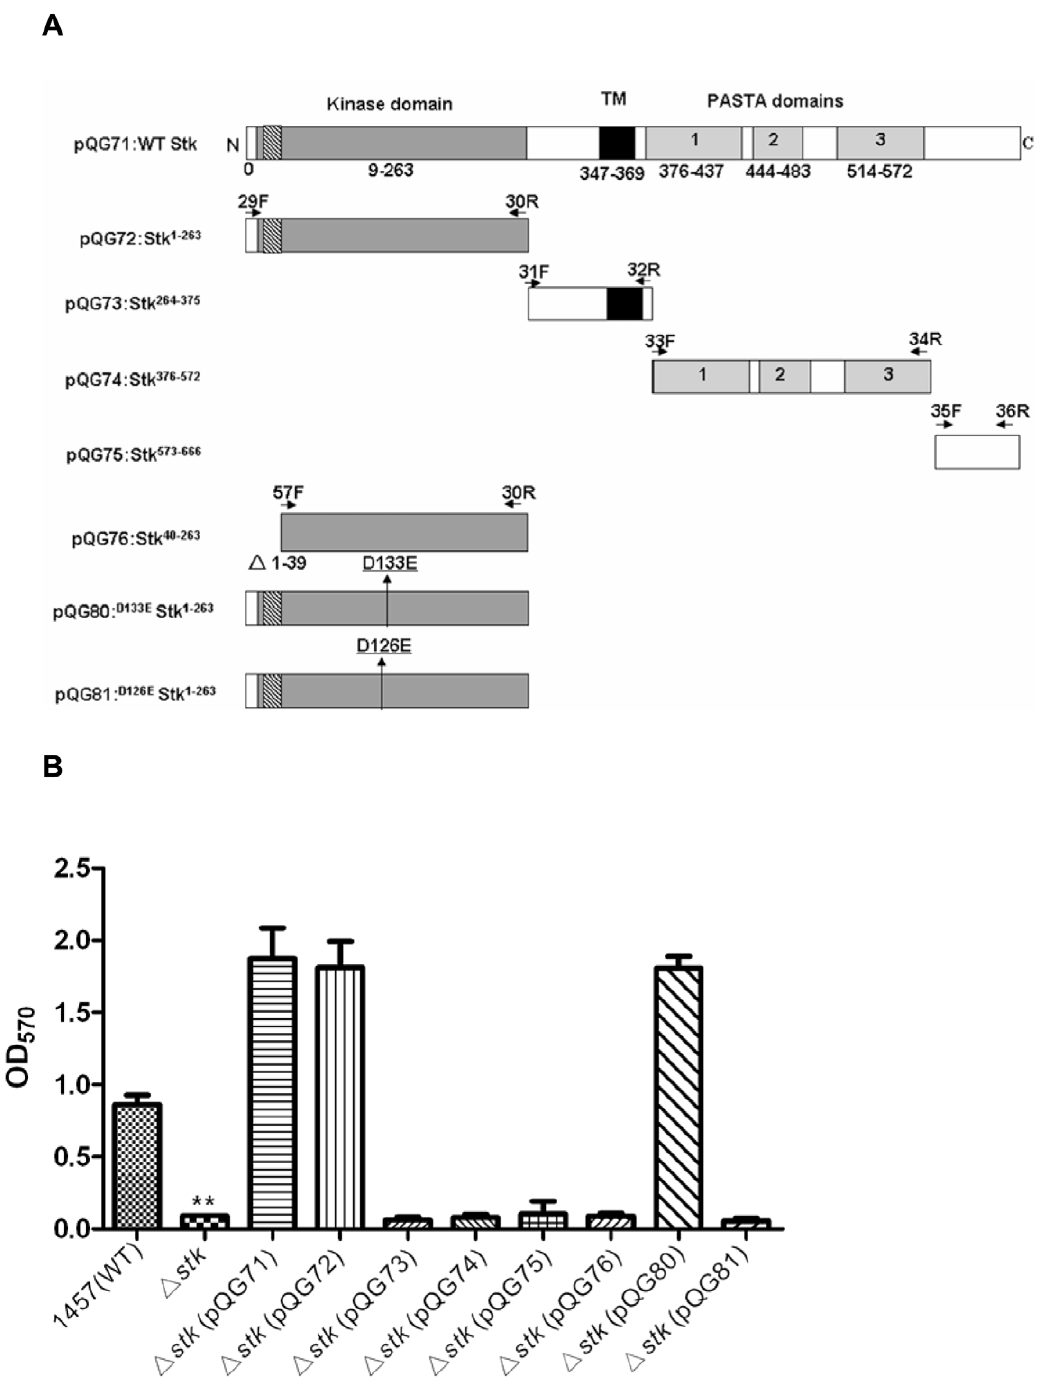
Figure 2. Stk influences biofilm formation invitro . A. Architecture of stk complementation constructs. Slashed lines denote the ATP-binding site of Stk. The primers used for the amplification of specific domains are indicated by arrows. TM, transmembrane. B. Influence of Stk and Stk domains on S. epidermidis biofilm formation. The stk mutant strain was complemented with plasmids expressing different domains of Stk: pQG71, full length; pQG72, kinase domain; pQG73, transmembrane domain; pQG74, PASTA repeated domain; pQG75, C-terminal domain; pQG76, kinase domain without ATP-binding site; pQG80, kinase domain with D133E mutation; pQG81, kinase domain with D126E mutation, and biofilm formation in comparison to the stk mutant and WT strains was determined in vitro by semiquantitative biofilm assays. Data were derived from three independent experiments, with 4 replicates in each experiment. **, P , 0.01 (versus WT). doi:10.1371/journal.pone.0025380.g002 Stk protein, only the kinase domain, or an inactivated kinase lacking the ATP binding cassette did not exhibit activity, showing domain, in which the ATP-binding cassette was deleted. In kinase that the cassette is crucial for kinase activity (Fig. 4A). Staur- assays, only the GST fusion construct with the kinase domain osporine, a potent protein kinase inhibitor, inhibited the WT Stk